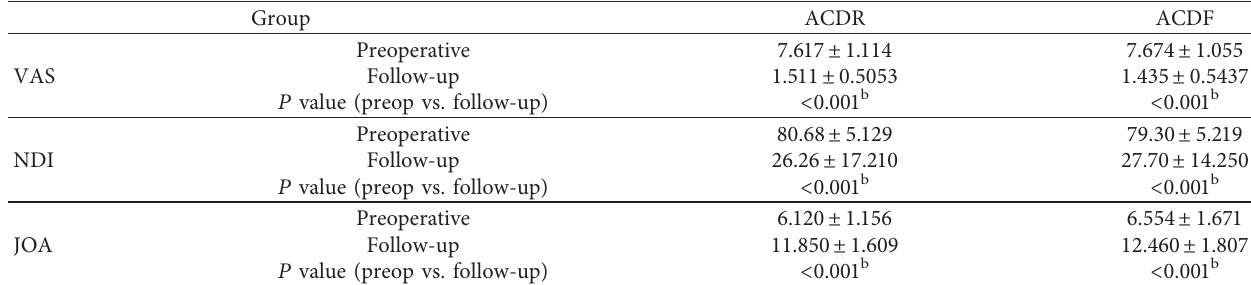
Table 3: Pain relief and dysfunction improvement a .